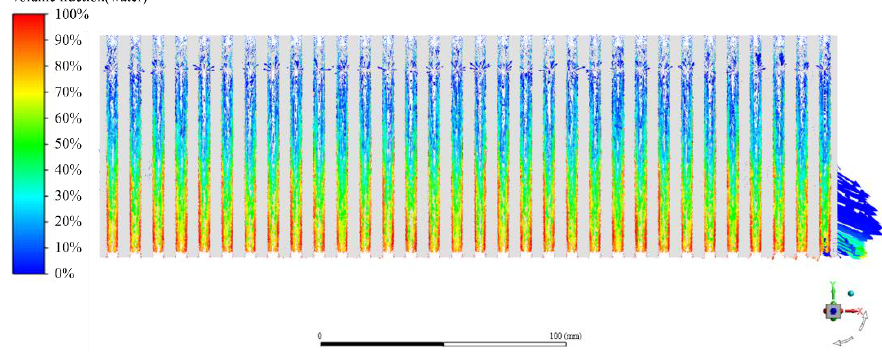
Figure 12. Velocity vectors near the wall of the corrugated pipe.